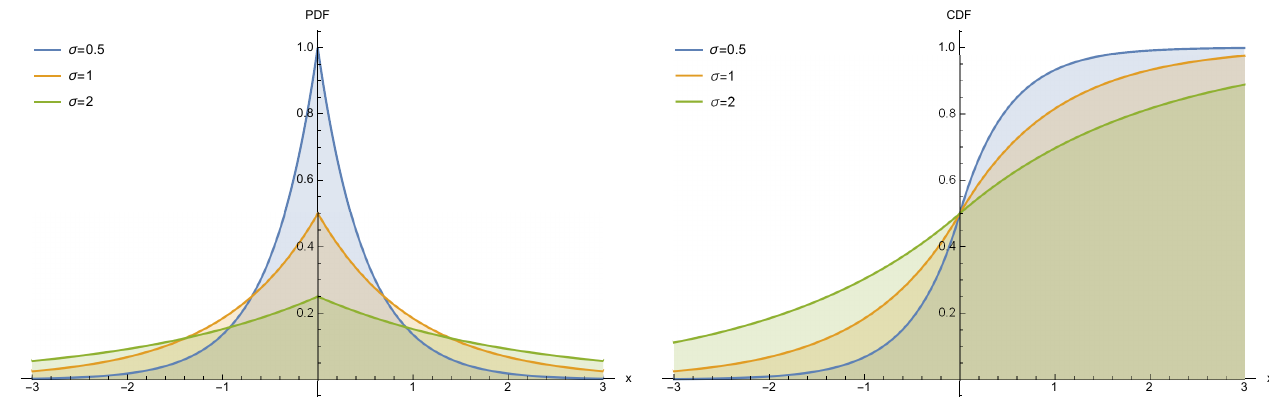
Figure 1. ( Left ) The PDFs of the Laplace distribution by varying the scale parameter. ( Right ) The CDFs of the Laplace distribution by varying the scale